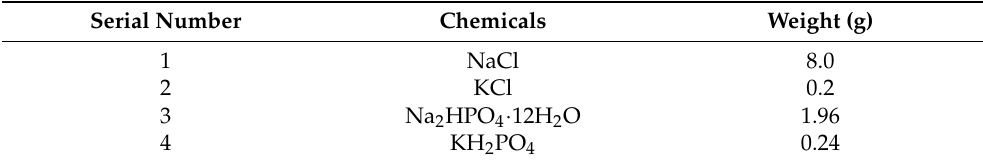
Table 2. Mixing ratios of 1 L PBS